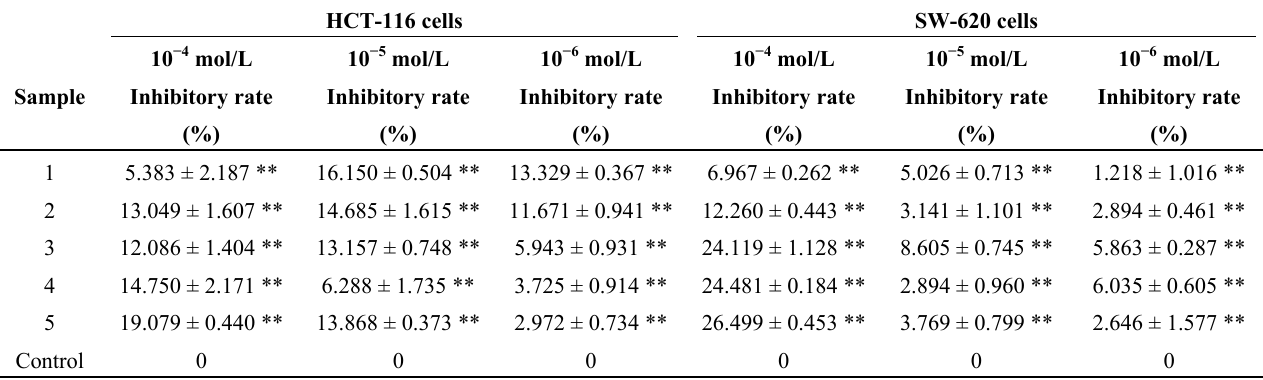
Table 3. Activity of compounds 1 – 5 on proliferation of the HCT-116 and SW-620 cells. HCT-116 cells SW-620 cells 10 − 4 mol/L 10 − 5 mol/L 10 − 6 mol/L 10 − 4 mol/L 10 − 5 mol/L 10 − 6 mol/L Sample Inhibitory rate Inhibitory rate Inhibitory rate Inhibitory rate Inhibitory rate Inhibitory rate (%) (%) (%) (%) (%) (%) 1 5.383 ± 2.187 ** 16.150 ± 0.504 ** 13.329 ± 0.367 ** 6.967 ± 0.262 ** 5.026 ± 0.713 ** 1.218 ± 1.016 ** 2 13.049 ± 1.607 ** 14.685 ± 1.615 ** 11.671 ± 0.941 ** 12.260 ± 0.443 ** 3.141 ± 1.101 ** 2.894 ± 0.461 ** 3 12.086 ± 1.404 ** 13.157 ± 0.748 ** 5.943 ± 0.931 ** 24.119 ± 1.128 ** 8.605 ± 0.745 ** 5.863 ± 0.287 ** 4 14.750 ± 2.171 ** 6.288 ± 1.735 ** 3.725 ± 0.914 ** 24.481 ± 0.184 ** 2.894 ± 0.960 ** 6.035 ± 0.605 ** 5 19.079 ± 0.440 ** 13.868 ± 0.373 ** 2.972 ± 0.734 ** 26.499 ± 0.453 ** 3.769 ± 0.799 ** 2.646 ± 1.577 ** Control 0 0 0 0 0 0 The data are expressed as mean ± SD of three independent experiments. (** p < 0.01 vs .